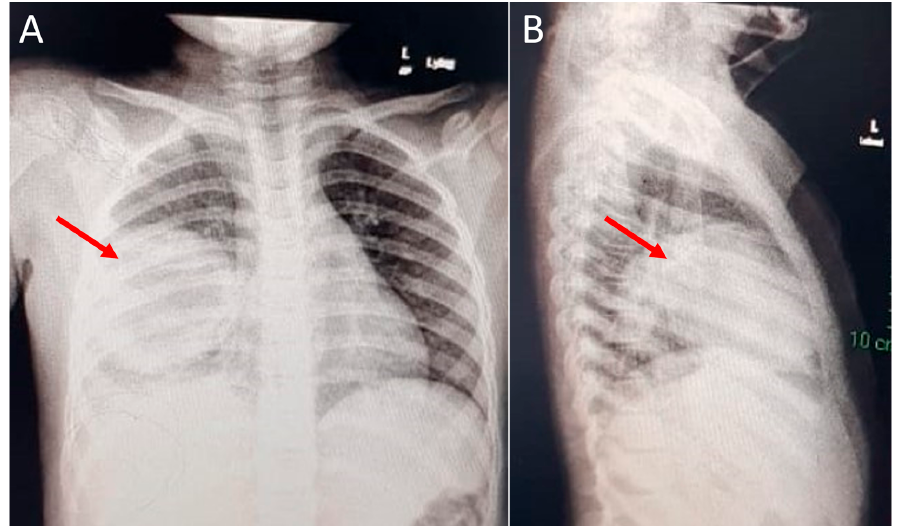
Figure 3. Chest X-ray (CXR) findings in case 4: ( A ) Anterior-posterior CXR view of the patient on admission shows a large, well-defined, homogenous opacity, rounded in shape, occupying the right middle lobe and silhouetting the right cardiac border; no definitive air bronchogram or cavitary changes were seen within the lesion (arrow). ( B ) Lateral CXR view of the patient shows the mass localized to the right middle lobe and encroaching upon the right lower lobe (arrow).